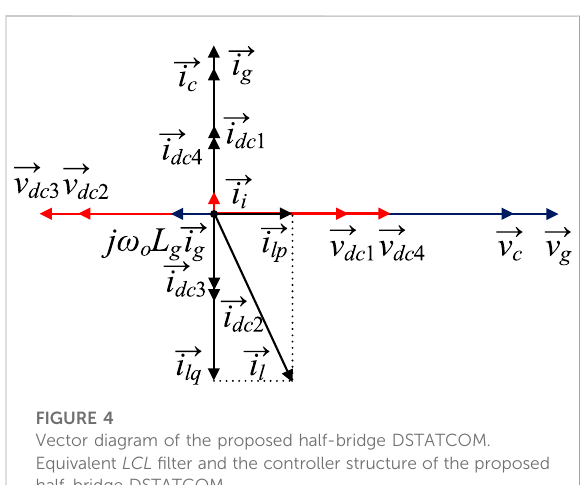
FIGURE 4 Vector diagram of the proposed half-bridge